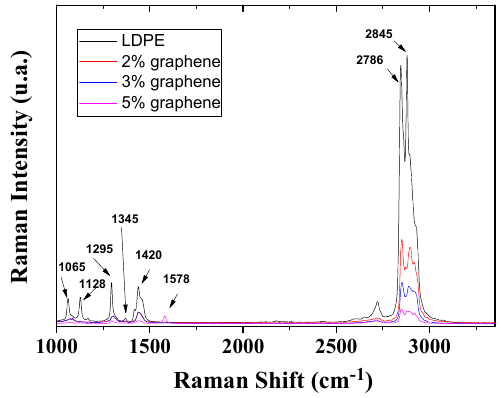
Materials 2020 , 13 , x FOR PEER REVIEW Figure 4. Raman spectra collected on various concentrations on melt-fabricated samples.